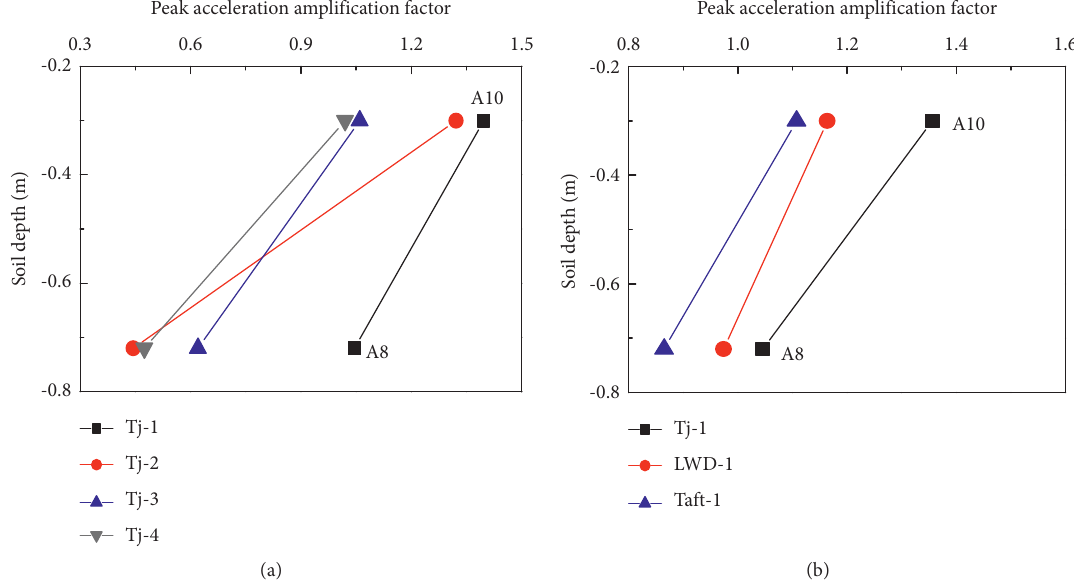
Figure 8: Acceleration amplification factor of the tunnels. (a) Tunnels under Tianjin wave. (b) Tunnels under different seismic